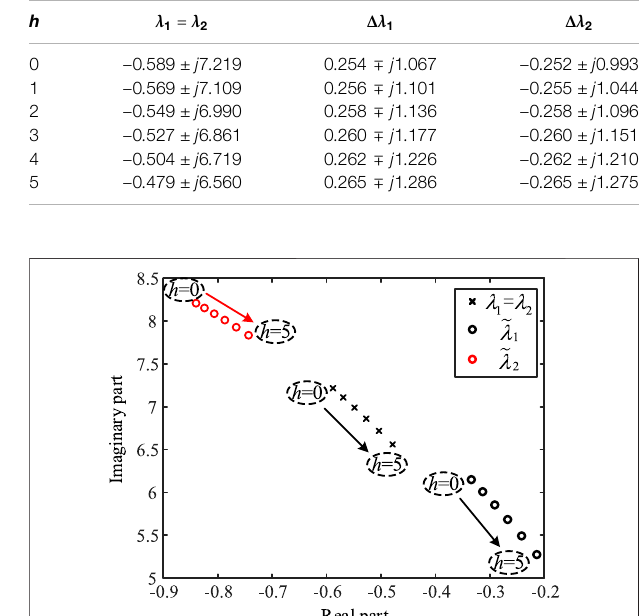
TABLE 2 | Calculation results for increasing electrical distance between PV farms.